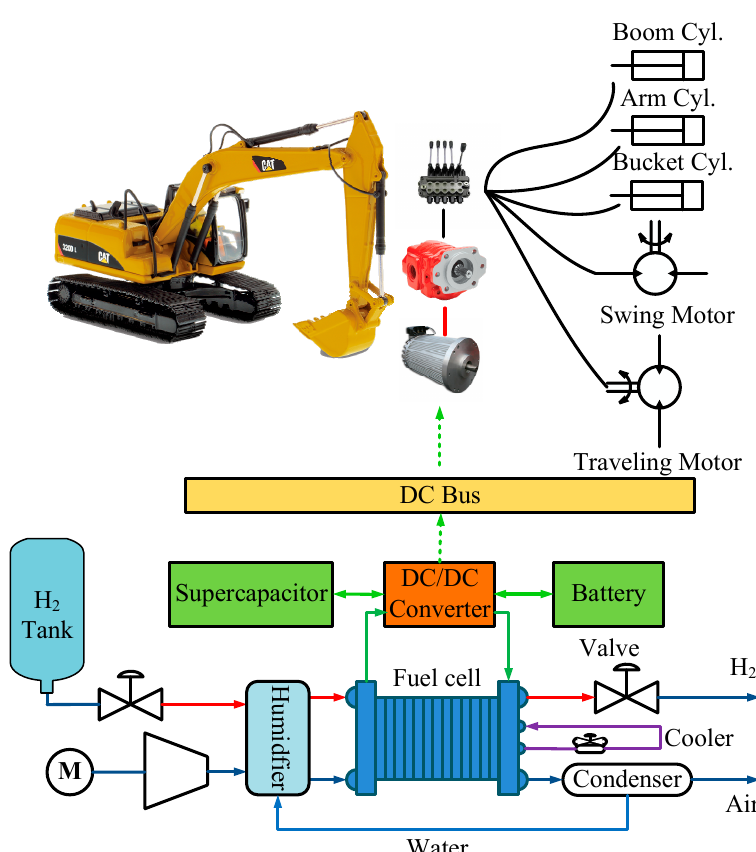
Figure 1. Proton-exchange membrane fuel cell-hydraulics excavator ( PEMFC-HE) structure.